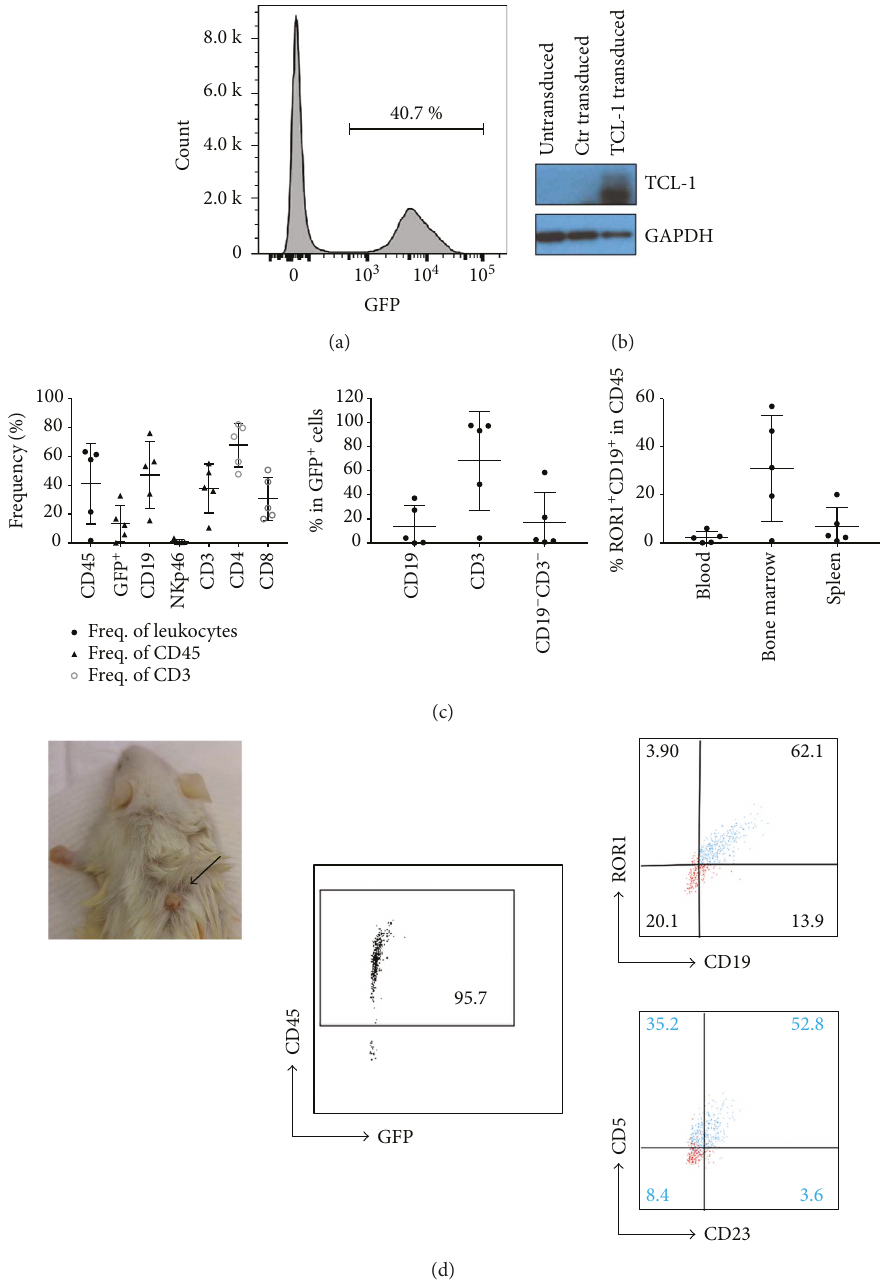
Figure 5: Engraftment of TCL-1-transduced human CD34 + cells in NSG mice could induce ROR1-expressing tumors. (a) Human CD34 + cells isolated from fetal liver tissues were transduced with lentivirus expressing TCL-1 GFP. Frequency of GFP-positive CD34 + cells after 4 days of lentiviral transduction is shown. (b) CD34 + cells transduced with lentivirus expressing TCL-1 (TCL-1 transduced) and control lentivirus (Ctr transduced) or untransduced were harvested and lysed 4 days after infection. Protein lysates were separated by gel electrophoresis, transferred to PVDF membranes by Western blotting, and probed with TCL-1-speci fi c antibody. The blot was also probed for GAPDH as a loading control. (c) Peripheral blood from NSG mice transplanted with lentiviral-transduced CD34 + cells was analyzed 3 months after reconstitution. The frequencies of di ff erent immune cell compartments are indicated. Frequencies of human CD45 + cells within the leukocyte gate, frequencies of GFP + cells, CD19 + B cells, NKp46 + NK cells, and CD3 + T cells within human CD45 + cells, and frequencies of CD4 + and CD8 + T cells within CD3 + cells are shown (left). The composition of the GFP + cells is shown (middle), and the frequency of CD19 + and ROR1 + cells within human CD45 + cells in the blood, bone marrow, and spleen of the mice is presented (right). Horizontal lines represent mean and SD. Data are from 2 di ff erent reconstitution cohorts with CD34 + cells derived from the same donor. (d) The mouse with the highest GFP + cells in the blood developed a tumor-like lump at the back as pointed by the arrow (left). Cells isolated from the tumor-like lump were analyzed by fl ow cytometry for the expression of human CD45 and GFP (left). The gated human CD45 + cells were further analyzed for CD19, ROR1, CD5, and CD23 expression. The ROR1 + CD19 + cell population is represented in